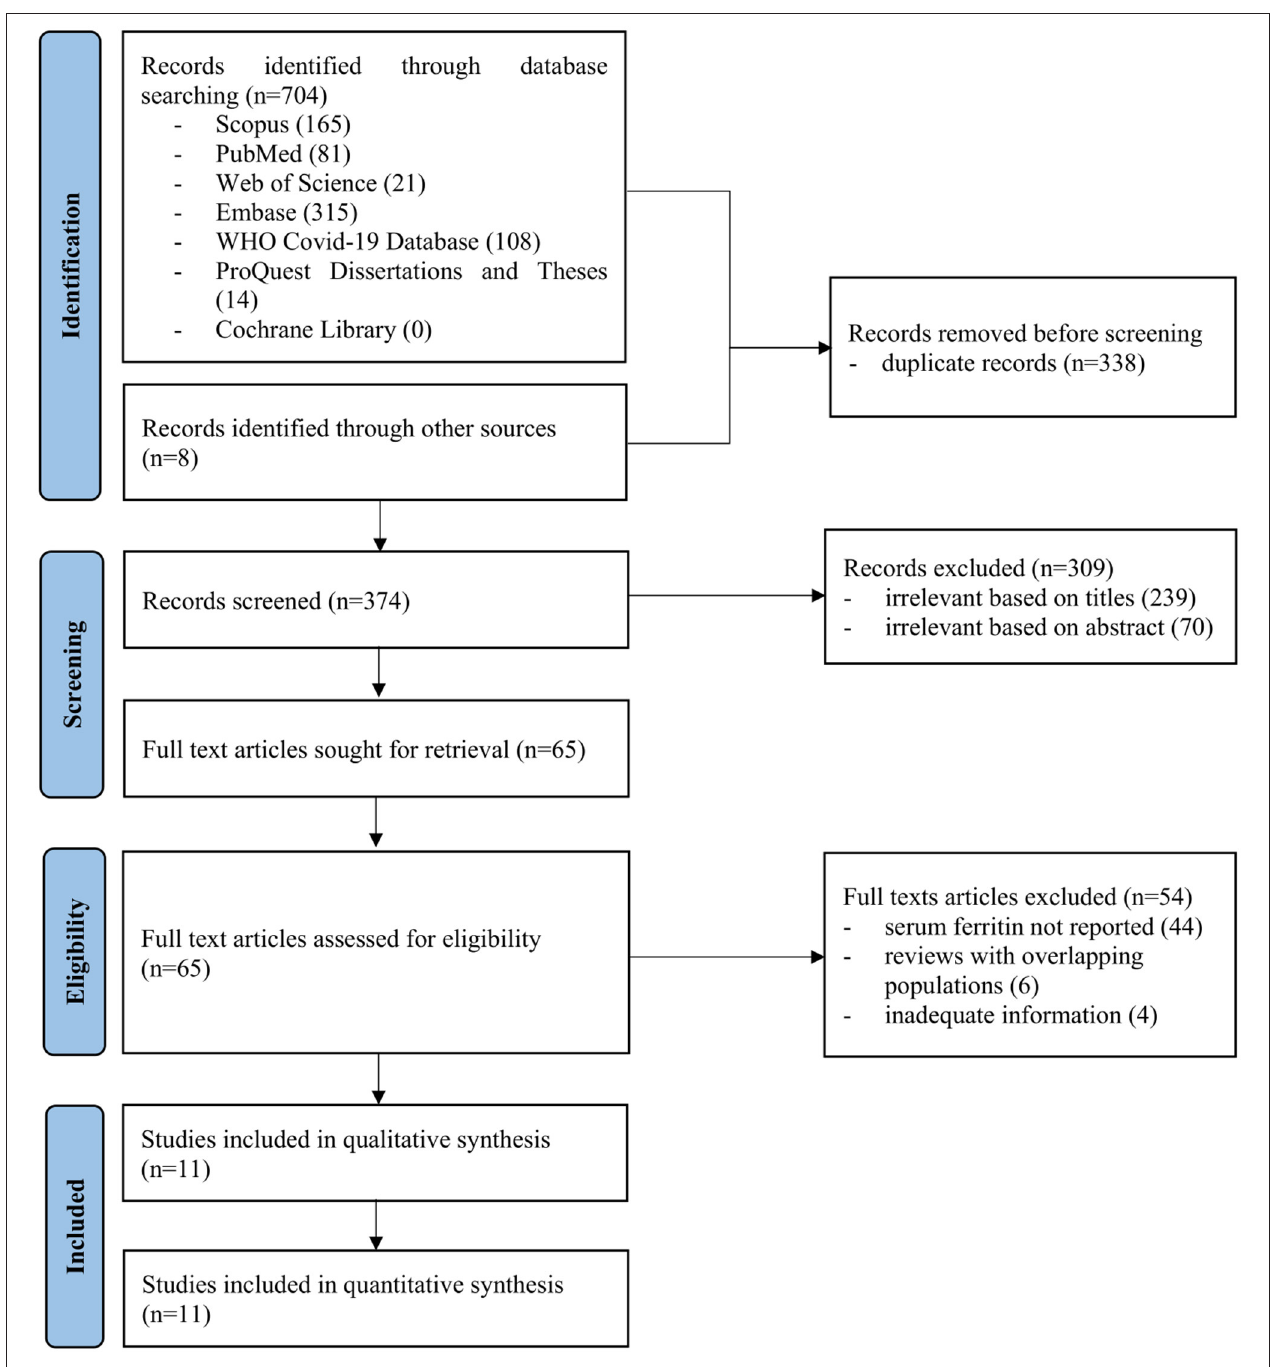
FIGURE 1 | Flow chart of study selection process (flow chart adapted from PRISMA).